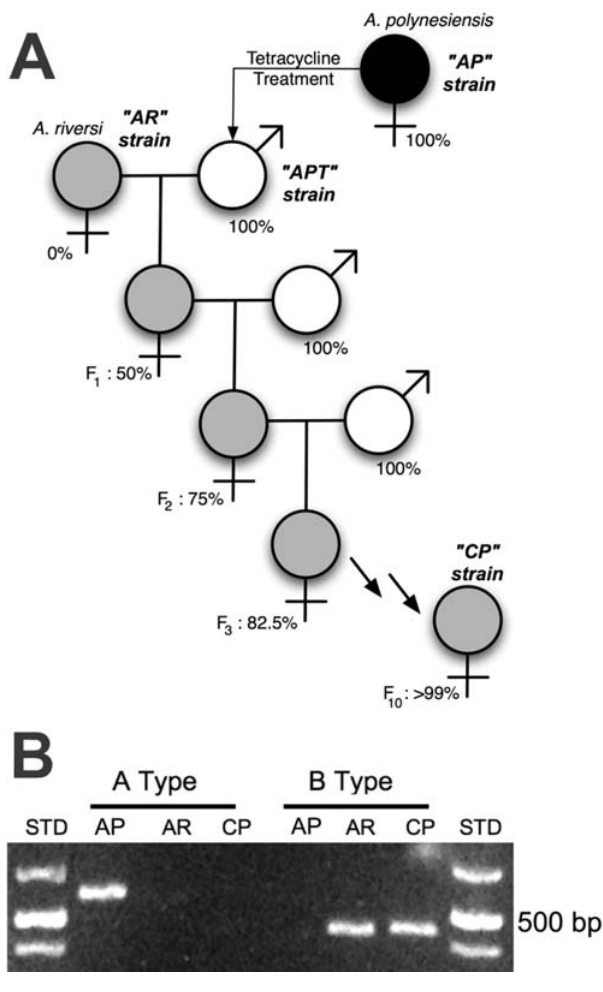
Figure 1. Introgression Strategy and PCR confirmation of Wolbachia infection type. (A) Wolbachia infection type is indicated by symbol shading: gray-filled symbols represent the B type Wolbachia infection from A. riversi ; the black-filled symbol represents the A type Wolbachia infection from A. polynesiensis (AP strain); unshaded symbols represent aposymbiotic individuals (APT strain). The theoretical percentage of A. polynesiensis genotype is shown as a percentage below symbols. The Wolbachia infection is maternally inherited, while the genotype is inherited from both parents. Repeated introgression of hybrid females with APT males results in the CP strain. (B) Wolbachia type-specific primers demonstrate that the CP strain infection type is the same as that of the original A. riversi strain (AR) and differs from the infection that naturally occurs in A. polynesiensis (AP). Wolbachia type- specific primers used in amplification reactions are indicated above the horizontal lines. STD is the molecular weight marker: 1kb DNA Ladder Plus (Fermentas Inc., Hanover,